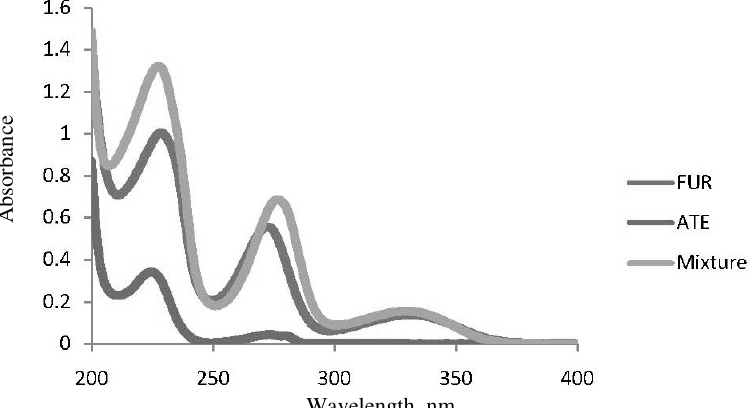
Figure 1. The UV-Vis absorption spectra ATE, FUR and mixture of tablets solutions.